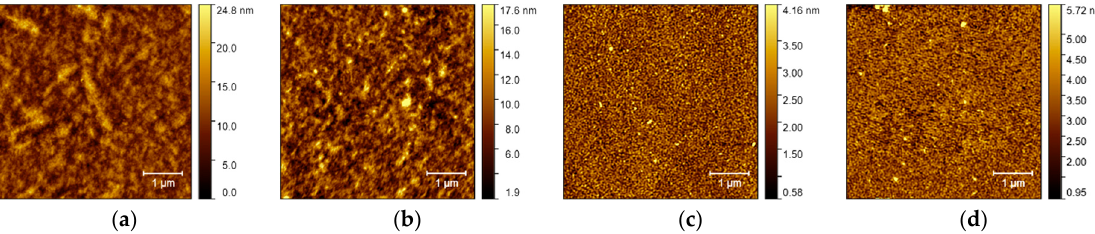
Figure 1. AFM images acquired in tapping mode of P3HT deposited on Si/SiO 2 substrate: ( a ) from toluene solution without adhesion promoter; ( b ) from toluene solution with Ti prime; ( c ) from oDCB solution without adhesion promoter; ( d ) from oDCB solution with Ti